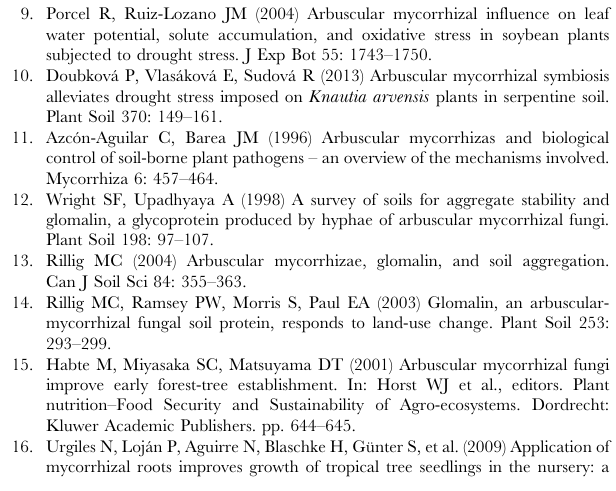
Table S1 Correlation matrix of soil factors and termi- nal restriction fragments (TRFs) of study areas in wet season (July 2010) which soils were sampled. Table S2 Summary of two-way analysis of variance for main and interaction effects of host plants ( Aquilaria crassna and Tectona grandis ), sites, and source of samples (root and soil) on AM fungal community diversity measured as the number of different TRFs per sample. Significant P-values are shown in bold. Table S3 Clone sequences and TRFs derived from roots and rhizosphere soils of T. grandis and A. crassna . Values in bold indicate TRFs that match the sizes of virtual digest fragments (with differences ranging from 0 to 7